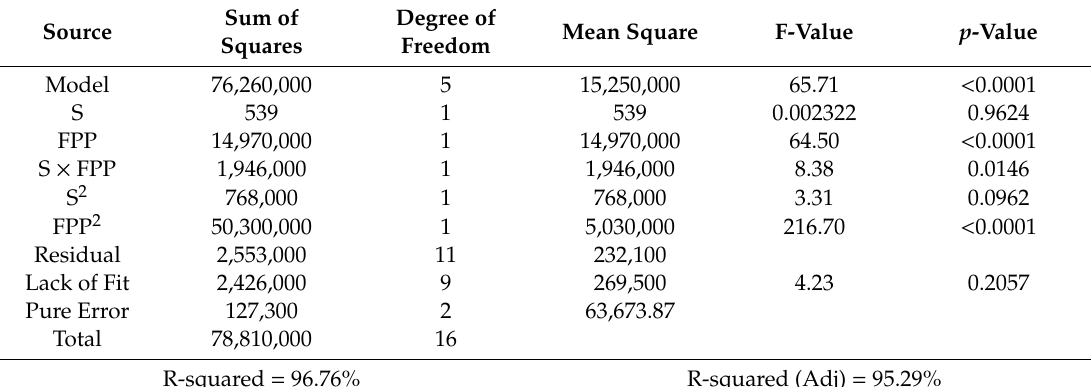
Table 5. Revised ANOVA of top kerf width.